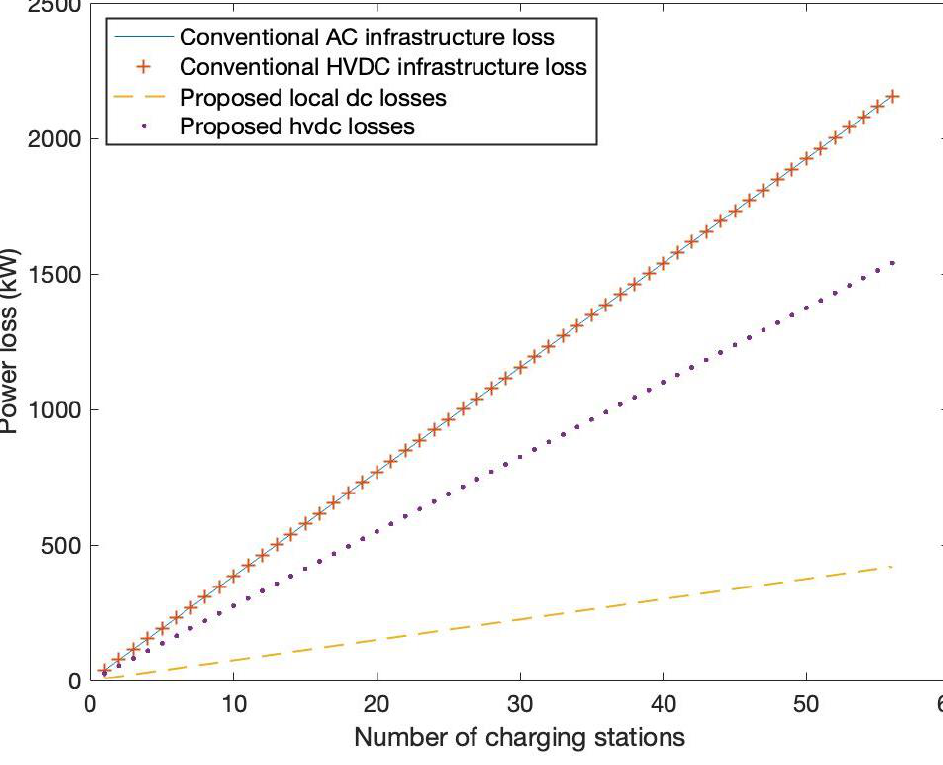
Figure 6. Increase in power loss with number of charging stalls.